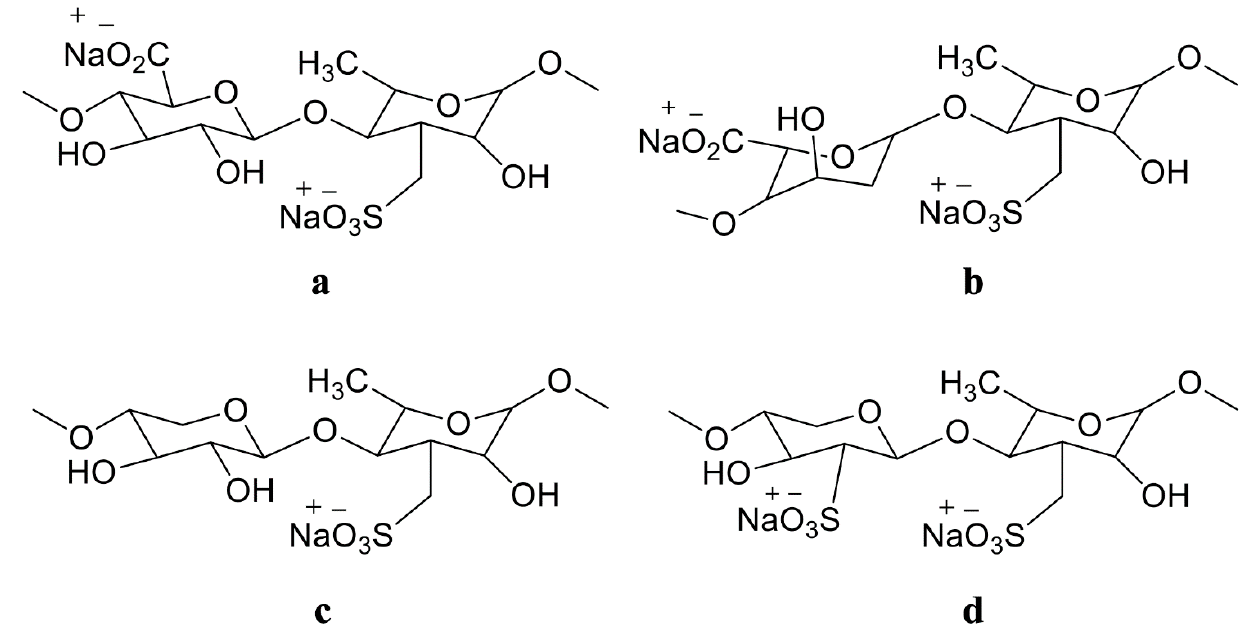
Figure 2. The Molecular structure of ulvan is drawn in Chemdraw 12.0 Ultra. Nomenclature and structure of the major repeating disaccharide units that comprise ulvan. Ulvanobiuronic acid A3s contains glucuronic acid attached to rhamnose 3-sulfate ( a ); while the similar B3s also contains rhamnose 3-sulfate but has iduronic acid ( b ) in the place of glucuronic acid. Ulvanobioses are comprised of rhamnose 3-sulfate attached to xylose ( c ); Xylose can contain a sulfate group, as seen in U2 ′ s,3s ( d ).